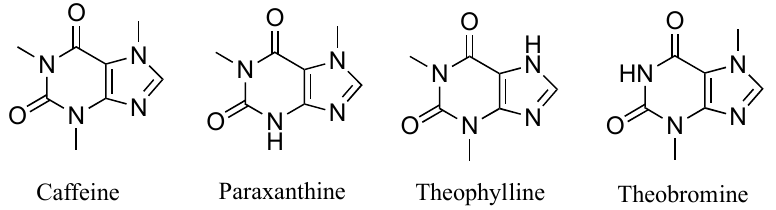
Figure 1. Chemical structures of caffeine and its primary metabolites.